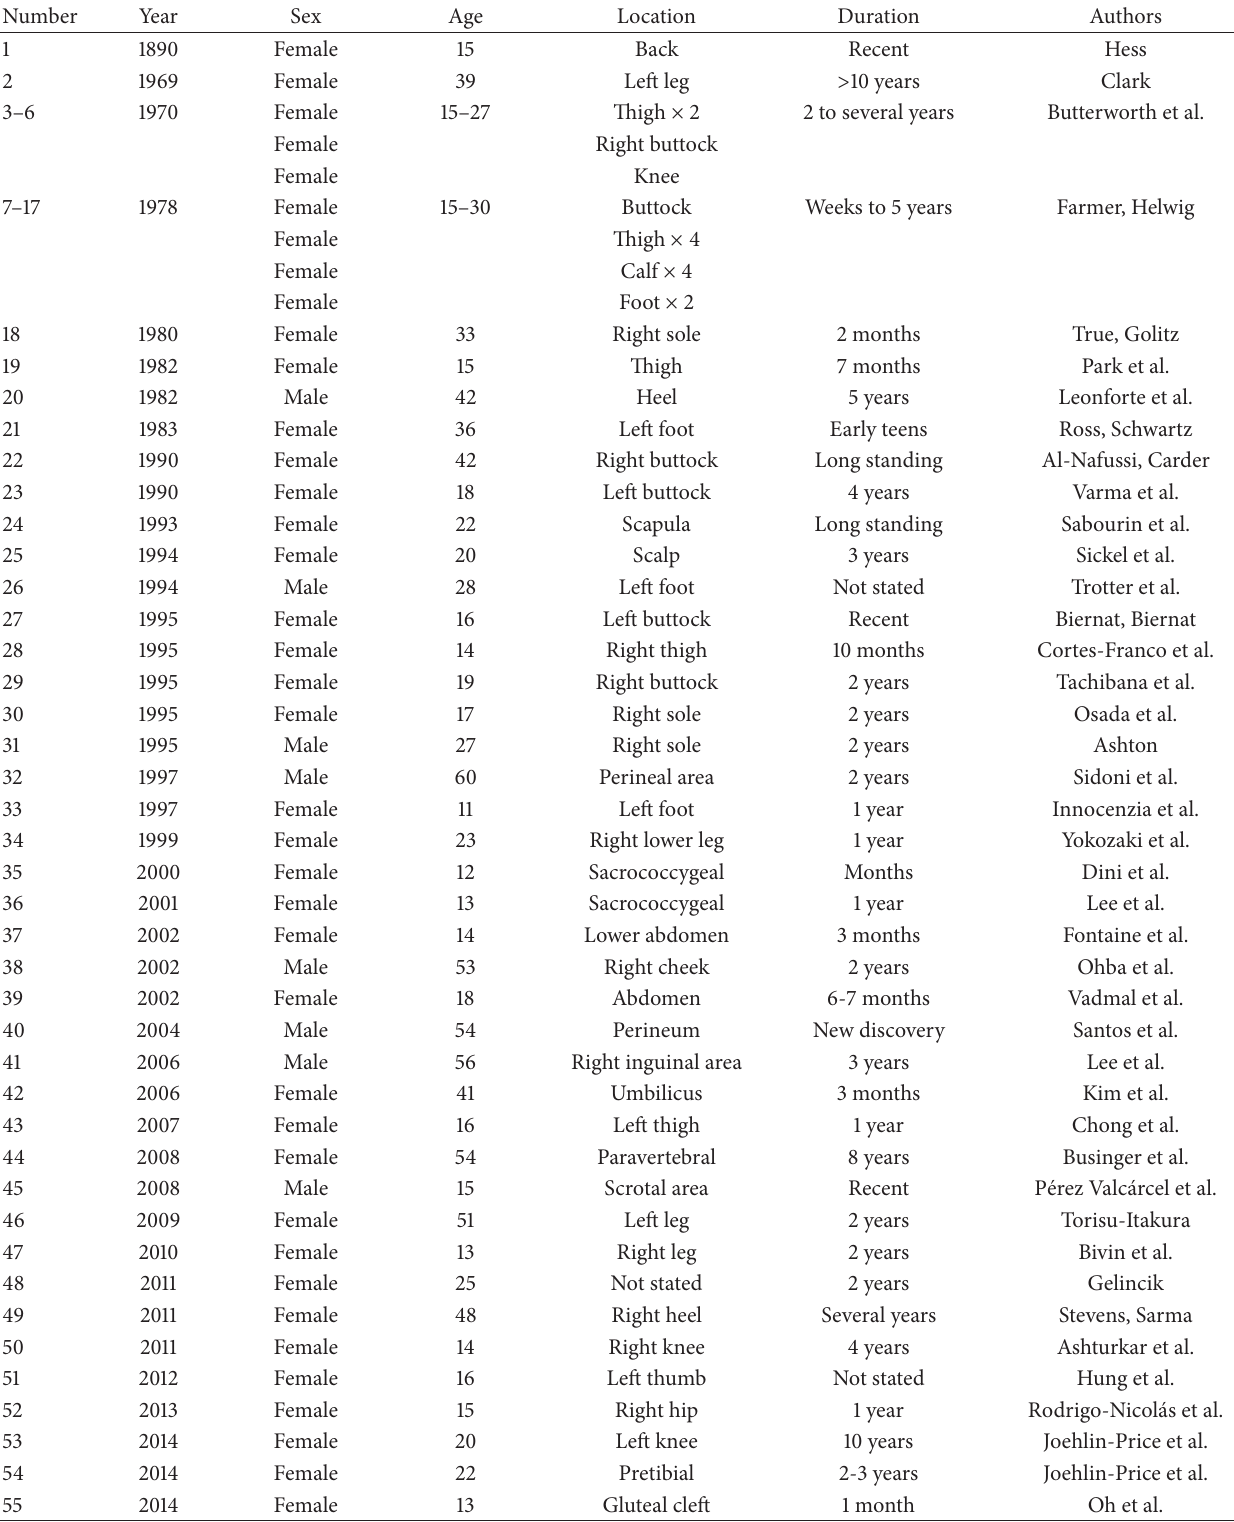
Table 1: List of previously reported cases of ciliated cutaneous cysts from 1890 to 2015. A total of 60 cases were reported, of which 50 were in female patients and 10 in males. Forty-eight (48) of these lesions were located in the lower extremity and its vicinity including the inguinal region, scrotum, perineum, buttock, gluteal cleft, and sacrococcygeal region. The other locations included the back, neck, scalp, cheek, abdominal wall, umbilicus, paravertebral region, and thumb. The reported ages ranged from 7 to